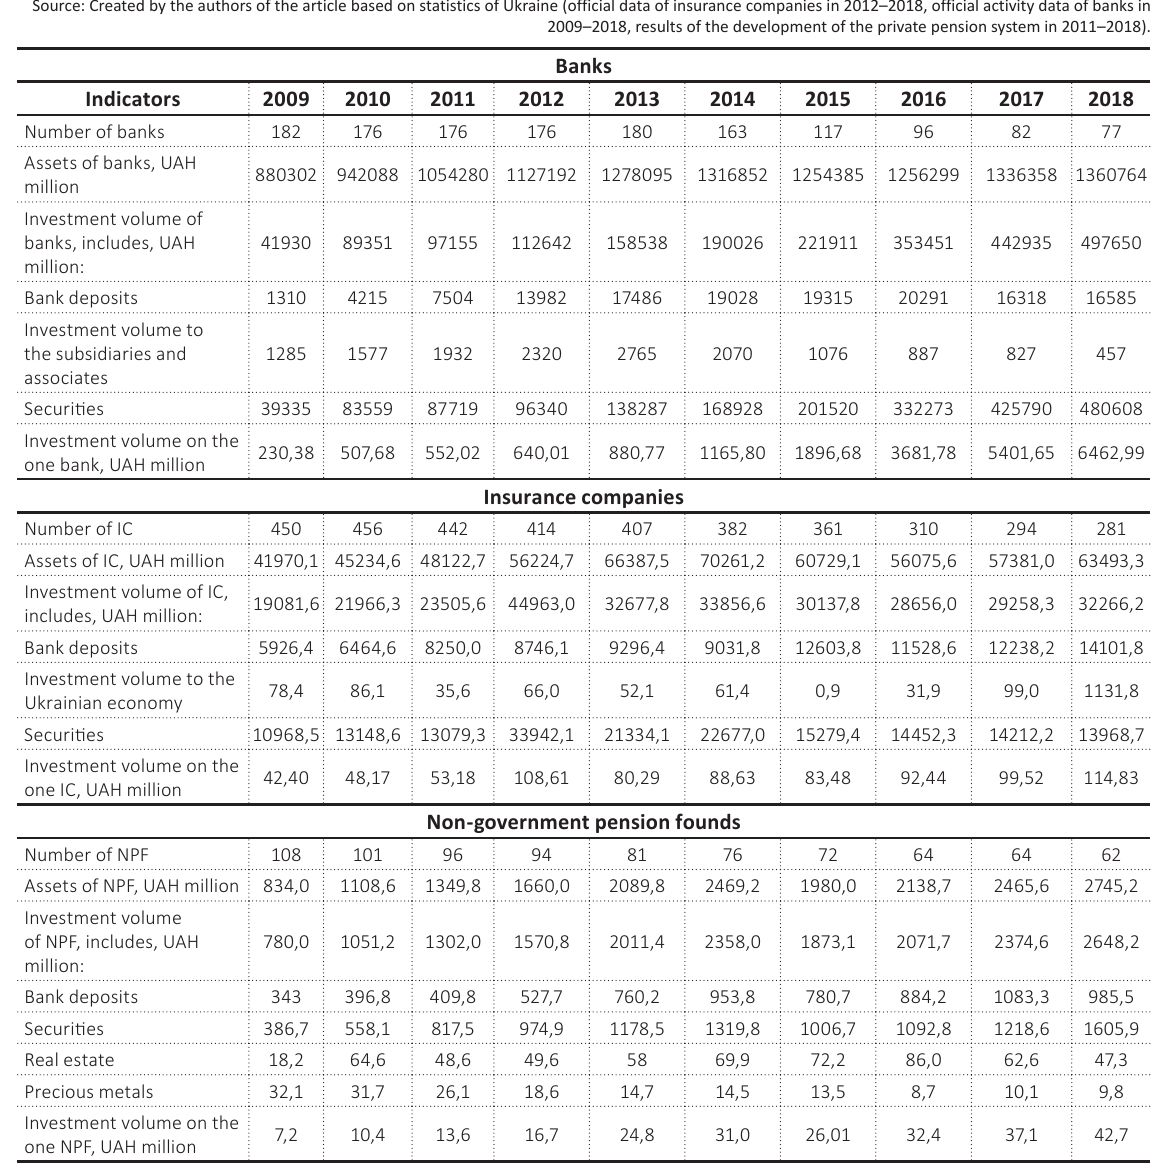
Table 1. Main indicators of financial intermediaries functioning in Ukraine,